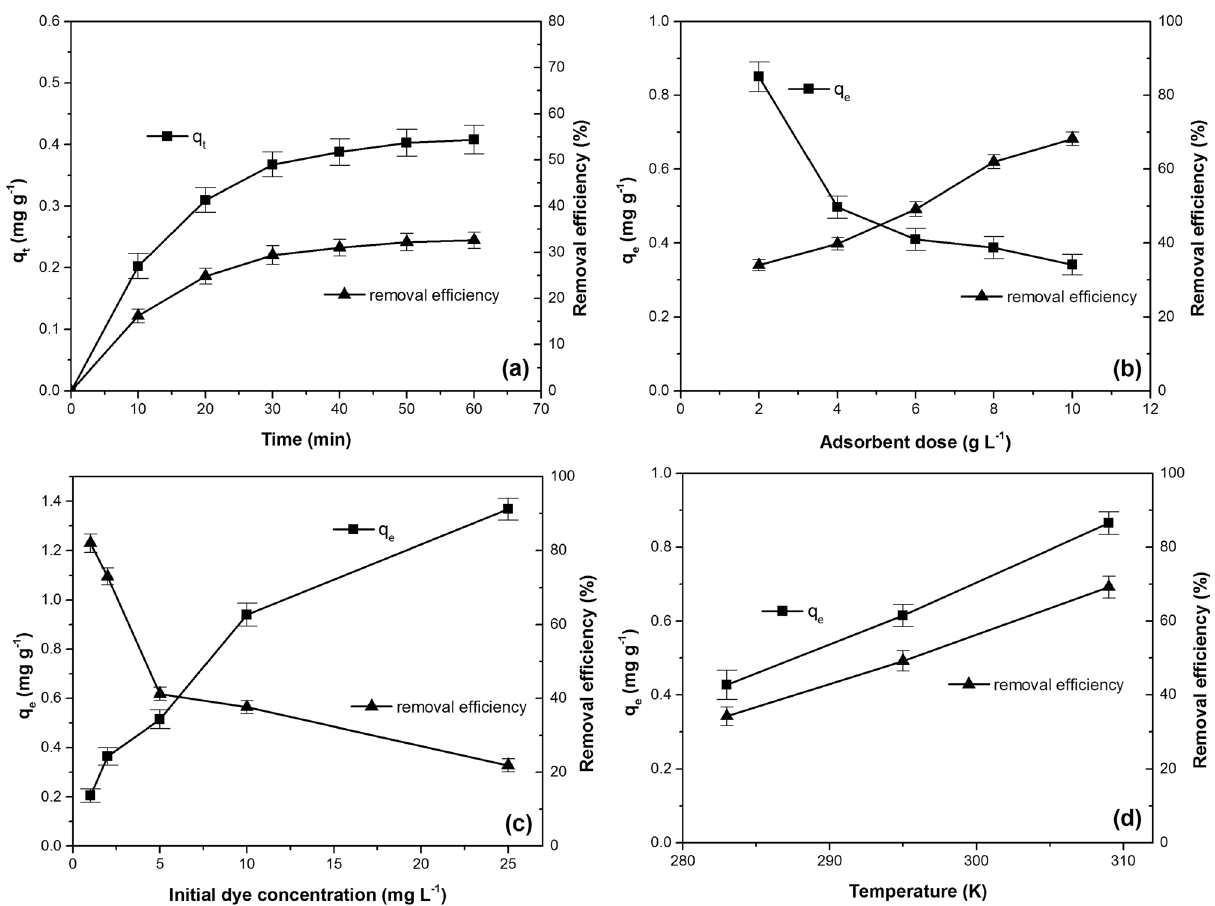
Figure 3. Effect of ( a ) time, ( b ) adsorbent dose, ( c ) initial dye concentration, ( d ) temperature on dye I adsorption onto PAC. (Adsorption conditions: ( a ): initial dye concentration: 5 mg L −1 ; adsorbent dosage: 4 g L −1 ; temperature: 295 K, ( b ): initial dye concentration: 5 mg L −1 ; contact time: 60 min; temperature: 295 K, ( c ): contact time: 60 min; adsorbent dosage: 4 g L −1 ; temperature: 295 K, ( d ): initial dye concentration: 5 mg L −1 ; contact time: 60 min; adsorbent dosage: 6 g L −1